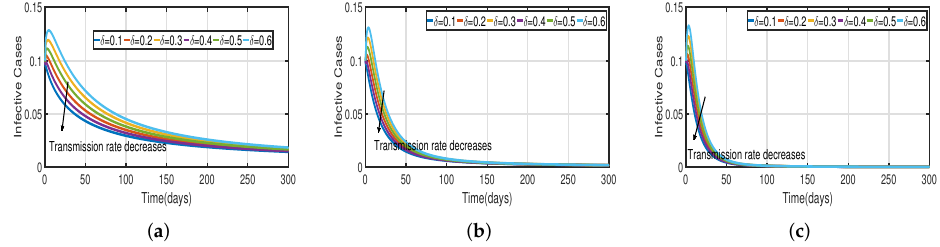
Figure 10. The trend of infected individuals regarding different transmission rates δ with a vaccination rate of 0.5%. ( a ) Fractional-order α = 0.62. ( b ) Fractional-order α = 0.83. ( c ) Fractional-order α = 0.94.